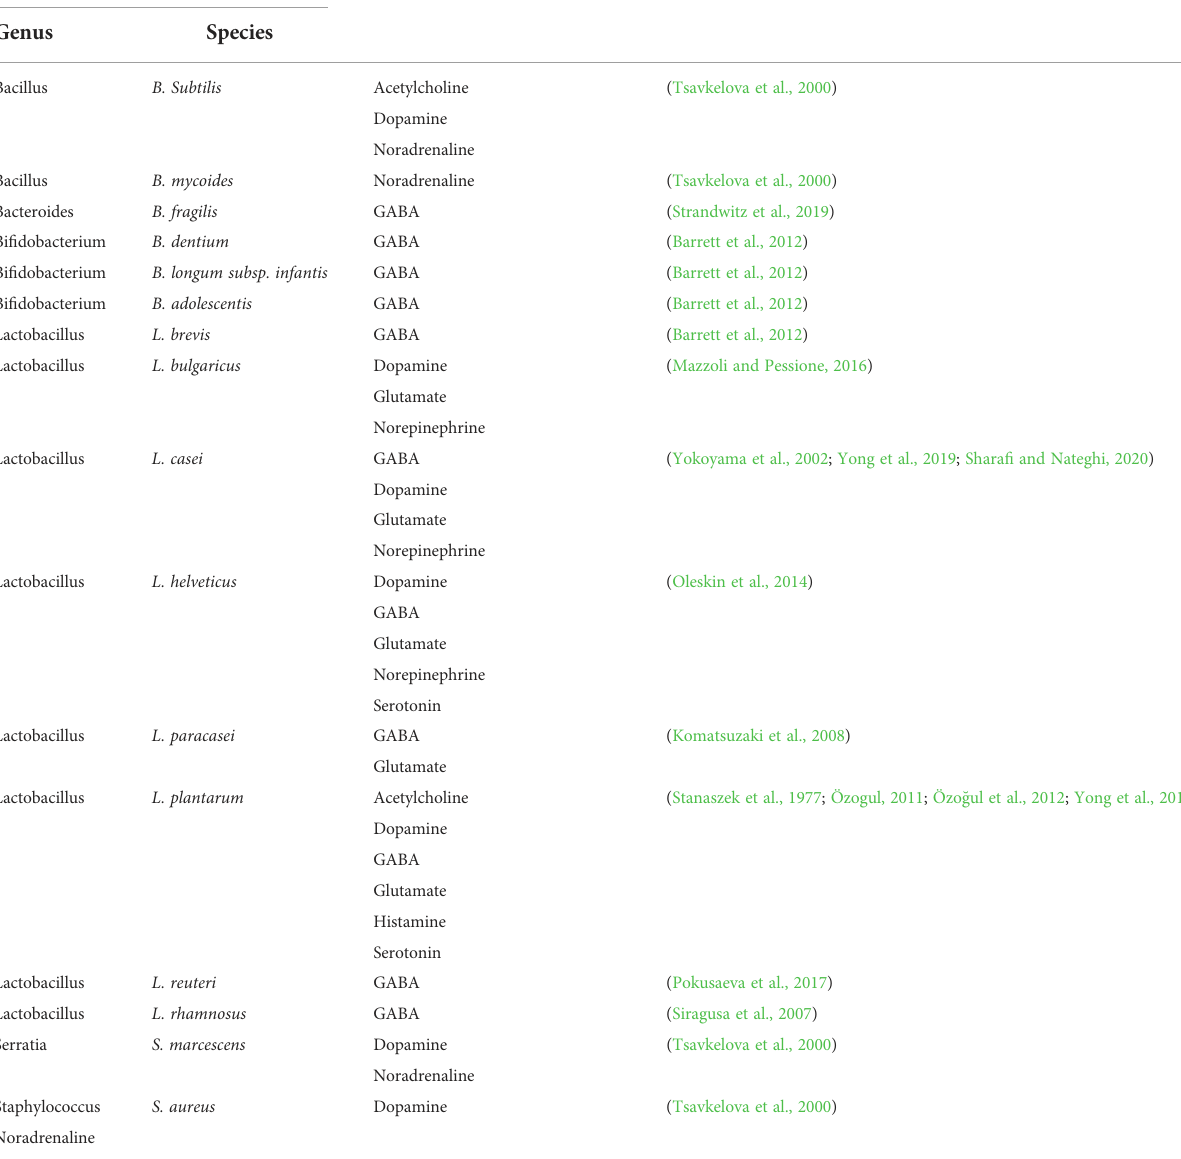
TABLE 2 Neurotransmitter producing bacteria. Microbiota Neurotransmitter